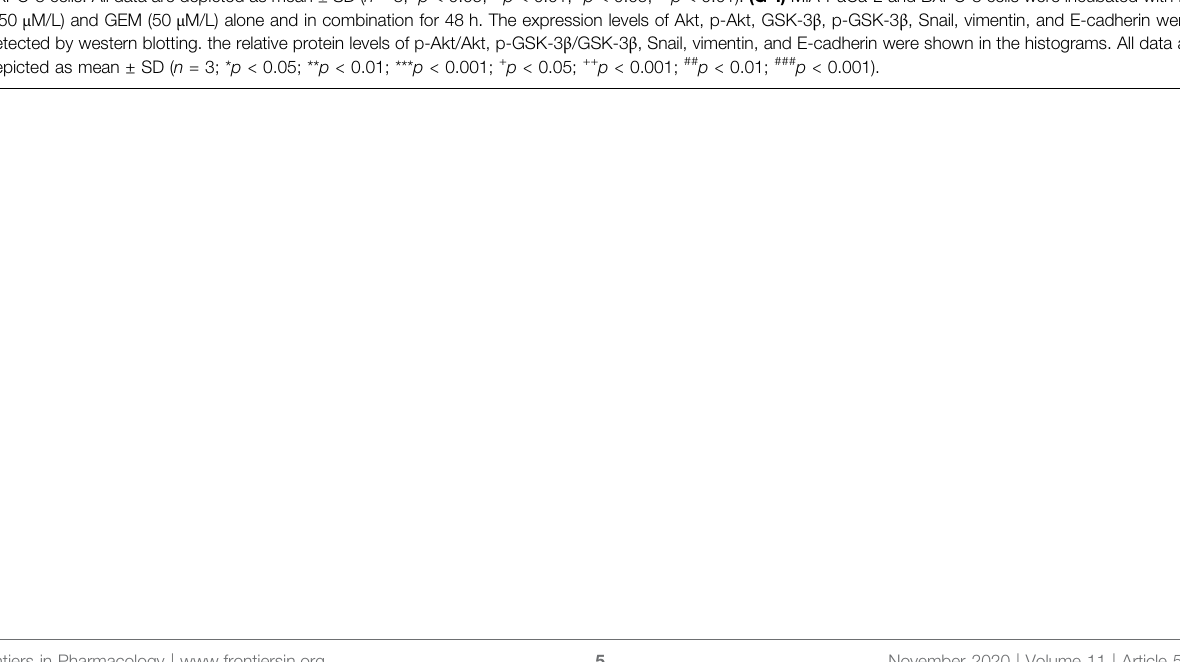
Frontiers in Pharmacology |